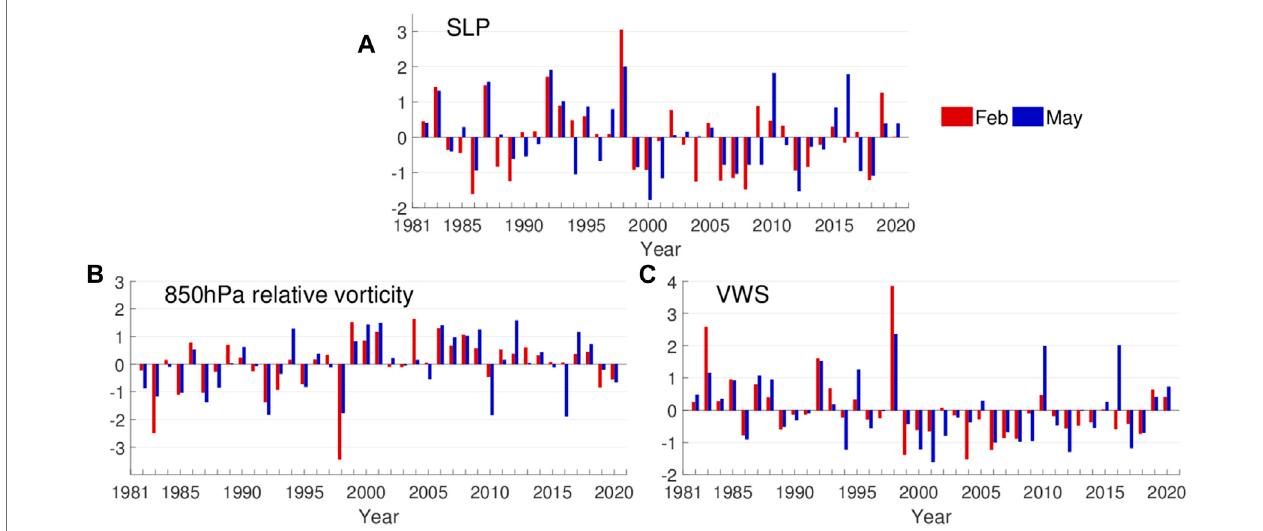
FIGURE 12 | Interannual variability of the CFSv2-predicted July (A) SLP anomaly averaged over the region (10 ° – 25 ° N, 90 ° – 150 ° E), (B) 850-hPa relative vorticity anomaly averaged over the region (12.5 ° – 22.5 ° N, 100 ° – 125 ° E), and (C) VWS anomaly averaged over the region (10 ° S – 15 ° N, 100 ° – 150 ° E) at 4- (red bars) and 2-months (blue bars) leads, affecting the TCGN over the WNP during 1982 –